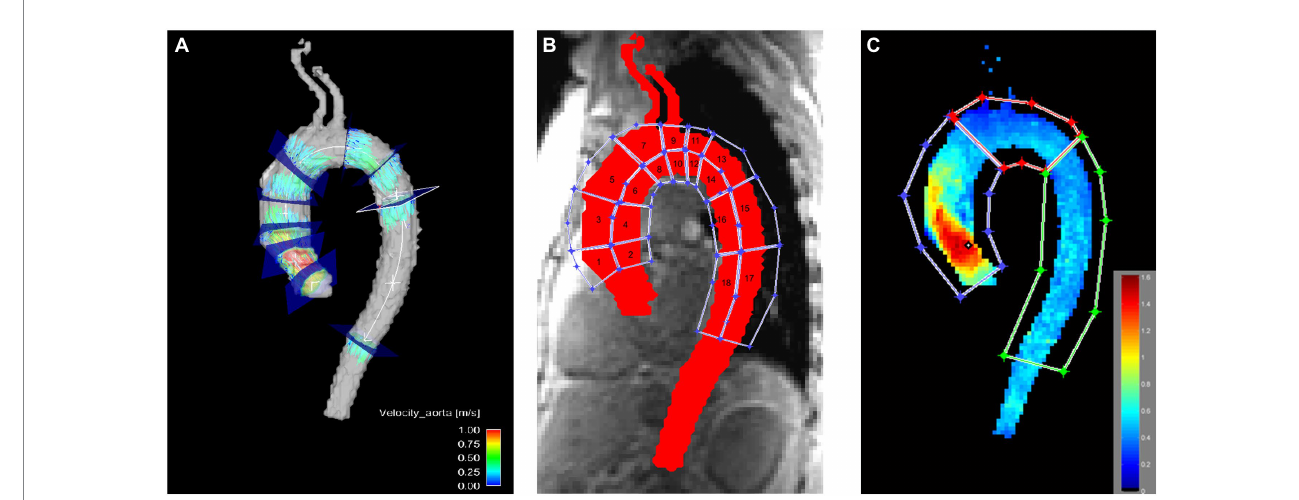
FIGURE 2 Visualization of the locations used for quantitative assessment in the thoracic aorta. (A) Flow was evaluated in nine axial planes in the aorta. (B) WSS was evaluated in 18 aortic wall regions. (C) Peak velocity was evaluated in the ascending aorta, the aortic arch and the descending aorta. Notice the elevated peak velocity in the ascending aorta due to the pathologic aortic